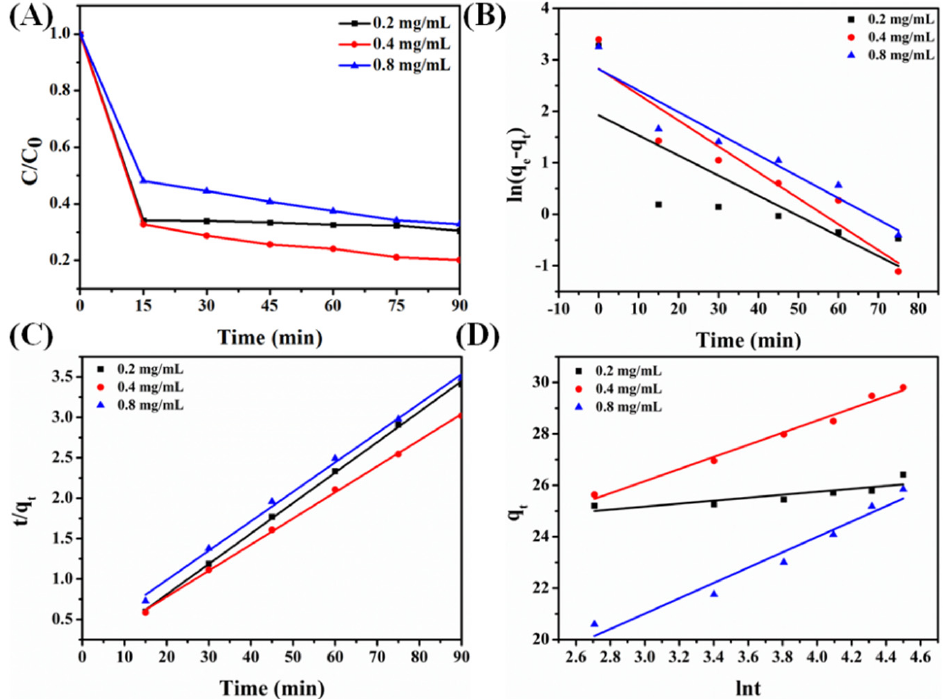
Figure 6. ( A ) Adsorption performance of 1 for BF solution. ( B – D ) Kinetic plots of BF adsorption by the pseudo − first − order kinetics model, pseudo − second − order kinetics model, and the Elovich equation.